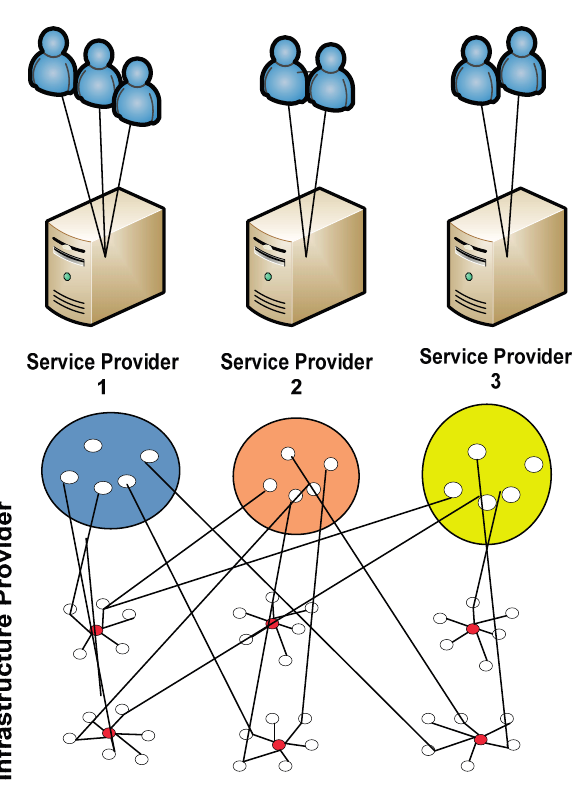
Figure 4. Network